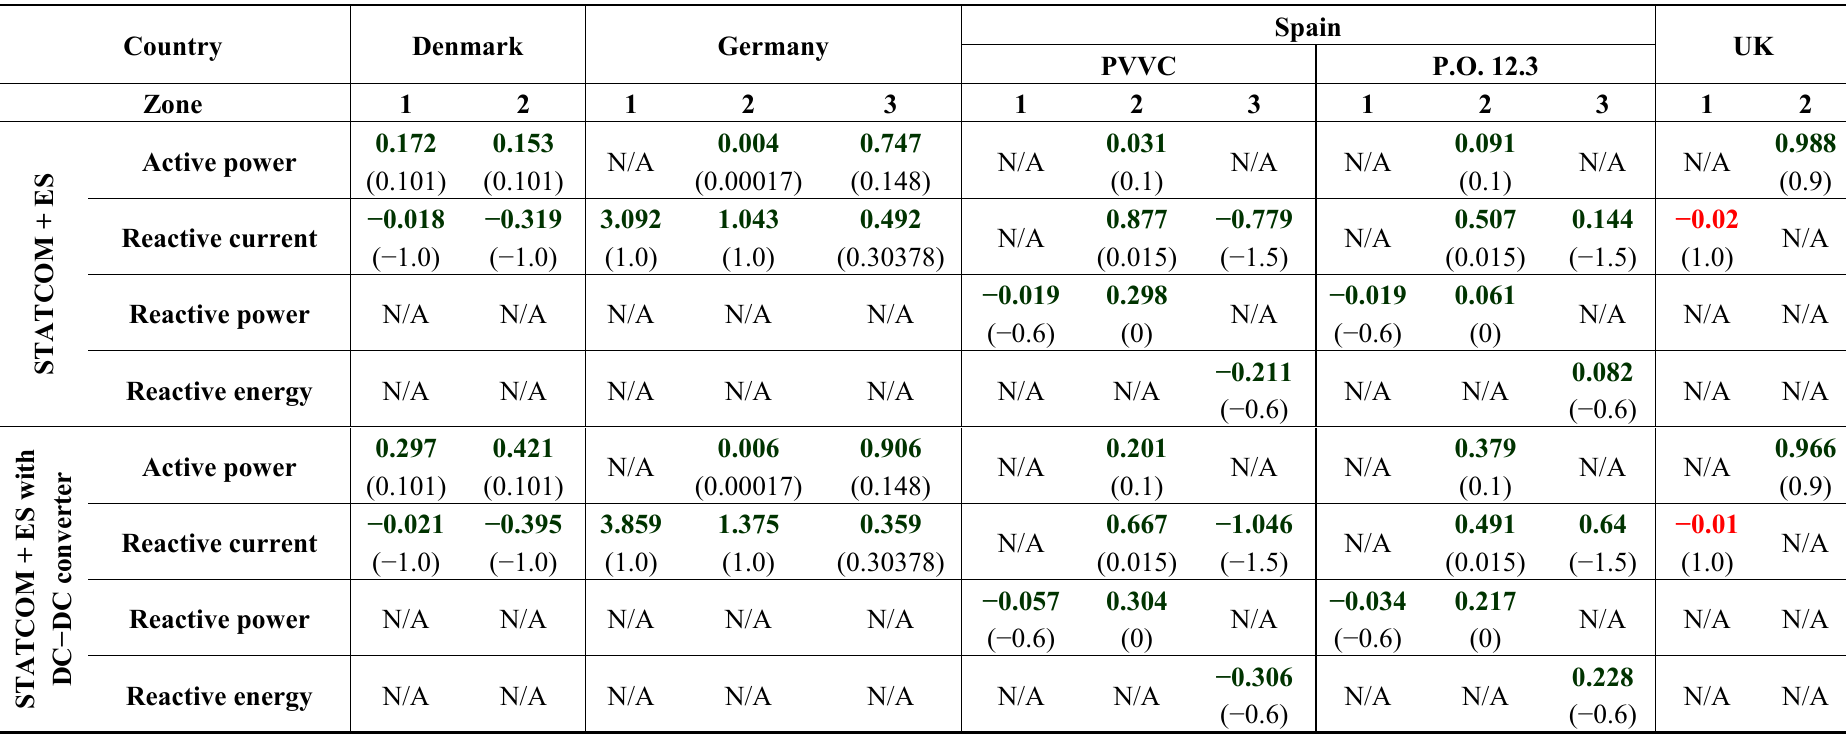
Table 4. Results and requirements, in p.u., of the different grid codes, with a STATCOM + ES and with a STATCOM + ES with DC-DC converter. Requirements are shown into brackets, red values are those where the specific requirement is not fulfilled and N/A means not